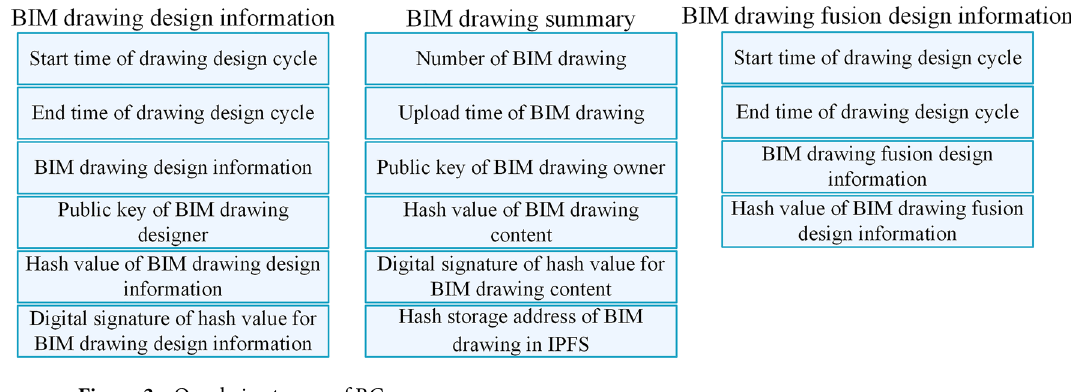
Figure 3. On-chain storage of BC.